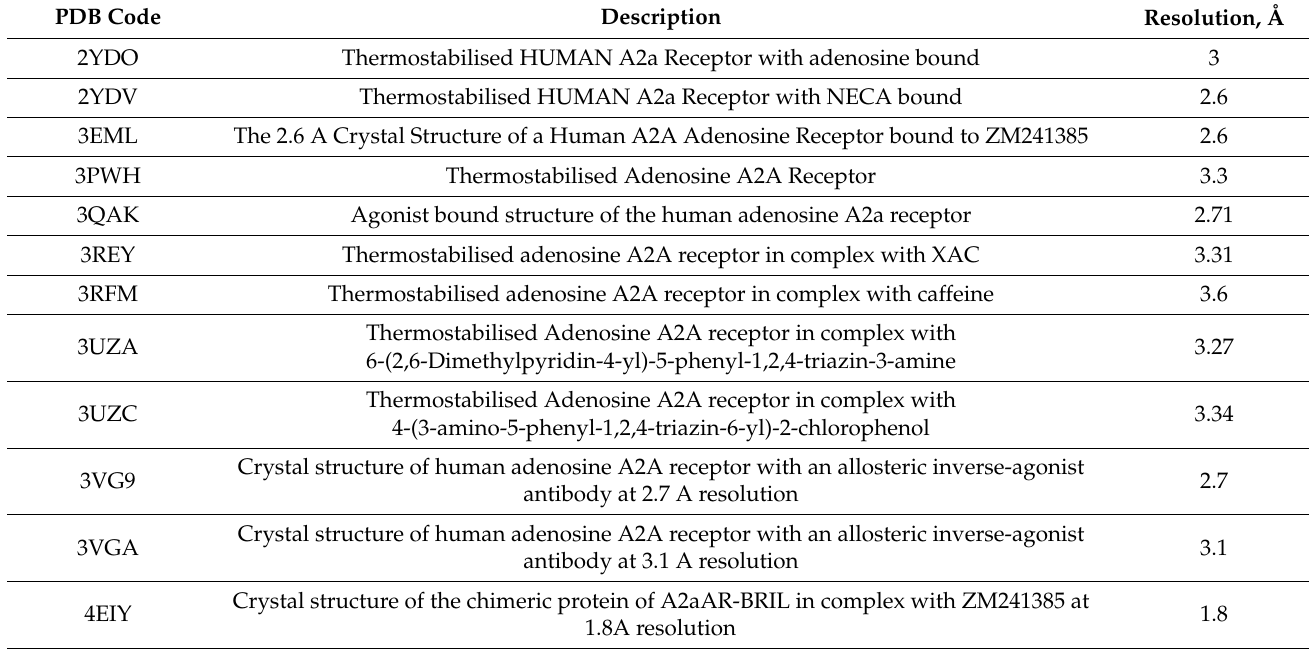
Table A4. A list of all adenosine A2a receptor (A2AR) structures used in Figure 6. Included are the PDB code, description, and resolution in